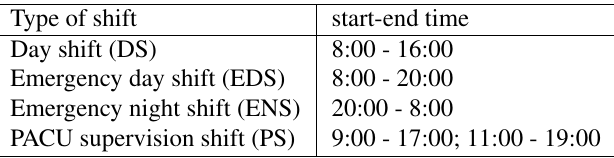
Table 1. Type of shifts, start and end time Type of